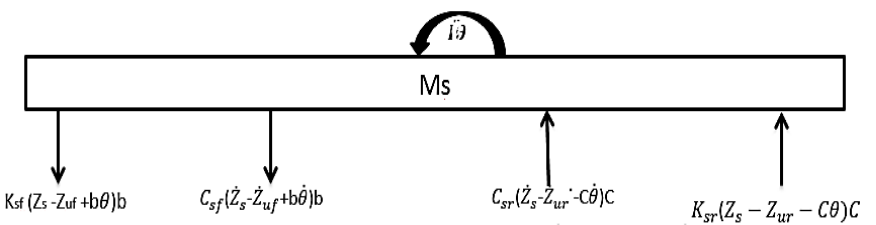
Figure 6. Free body diagram for sprung mass exhibiting (pitch